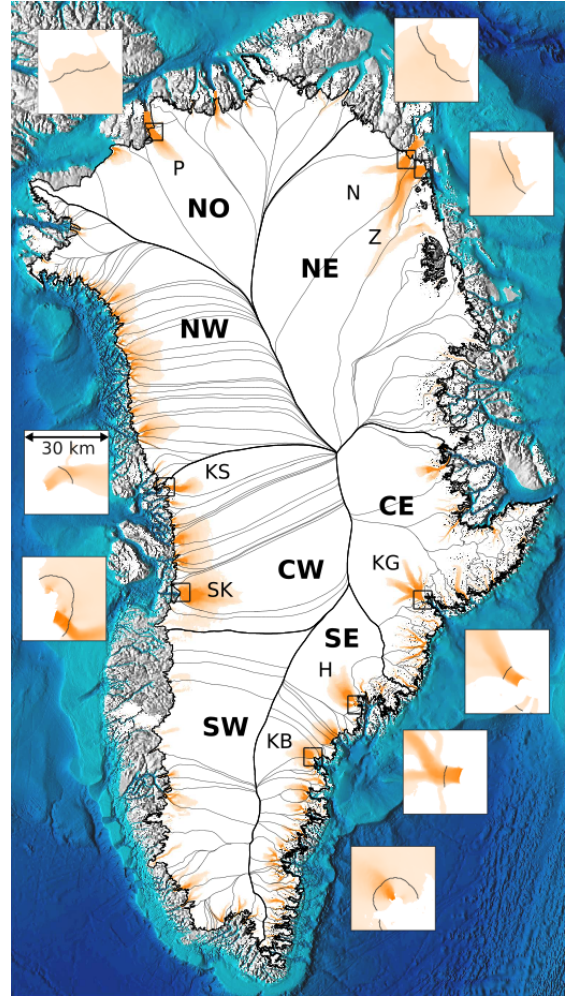
Figure 1. Overview showing fast-flowing ice (orange, greater than 100myr − 1 ) and the gates for eight major discharging glaciers (Fig. 6). Gates are shown as black lines in inset images. Each inset is 30km × 30km, and they all have the same color scaling but differ- ent than the main map. Insets pair with nearest label and box. On the main map, regions from Mouginot and Rignot (2019) are designated by thicker black lines and large bold labels. Sectors (same source) are delineated with thinner gray lines, and eight major discharging glaciers are labeled with smaller font. H: Helheim Gletsjer (Hel- heim Glacier), KB: Køge Bugt (Køge Bay), KG: Kangerlussuaq Gletsjer (Kangerlussuaq Glacier), KS: Kangilliup Sermia (English: Rink Glacier; Danish: Rink Isbræ), N: Nioghalvfjerdsbræ, P: Peter- mann Gletsjer (Petermann Glacier), SK: Sermeq Kujalleq (English: Jakobshavn Glacier; Danish: Jakobshavn Isbræ), and Z: Zachariae Isstrøm. Basemap terrain (gray), ocean bathymetry (blues), and ice mask (white) come from BedMachine.